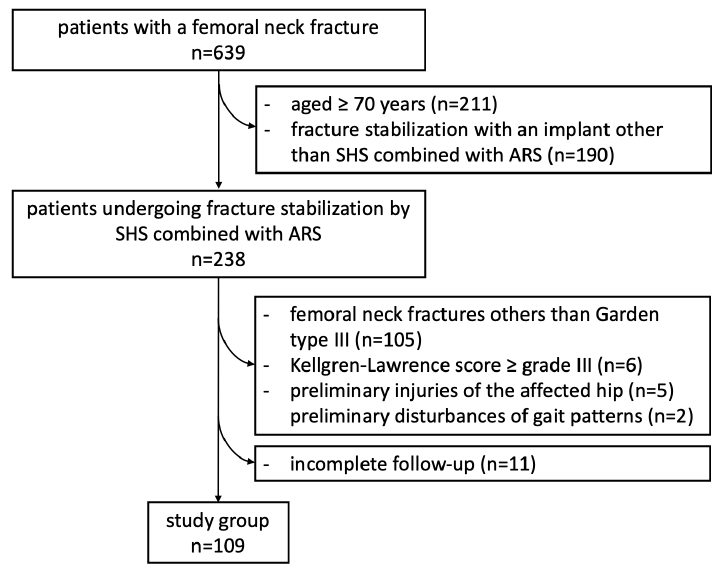
Figure 1. Overview on patients’ inclusion process .